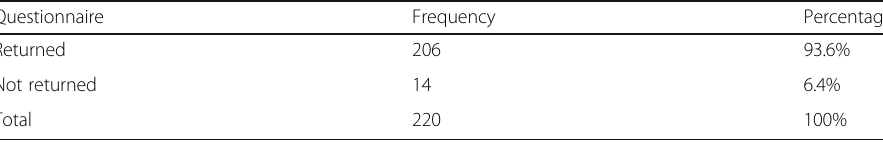
Table 3 Response rate of questionnaire